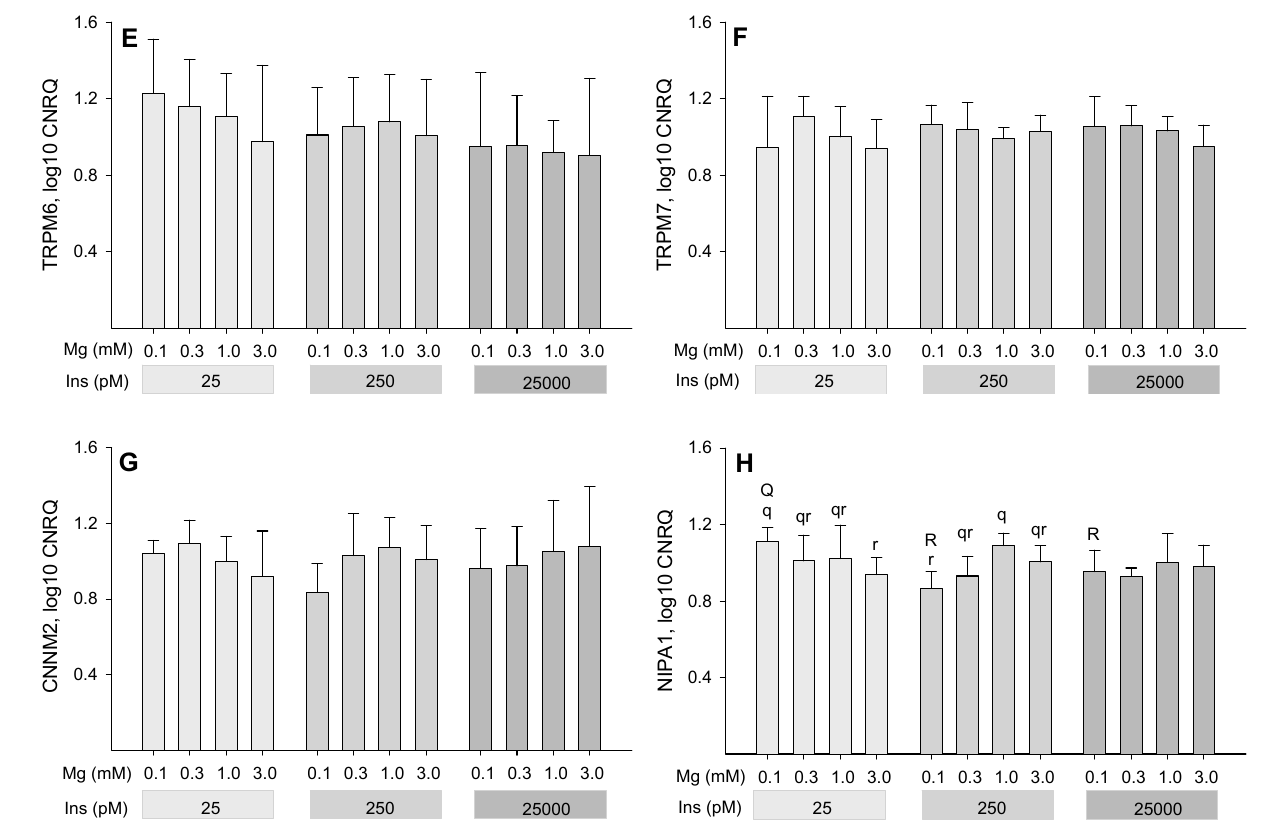
Figure 4. Relative mRNA expression (log10 CNRQ) of magnesium-responsive genes SLC41A1 ( A ), SLC41A2 ( B ), SLC41A3 ( C ), MAGT1 ( D ), TRPM6 ( E ), TRPM7 ( F ), CNNM2 ( G ) and NIPA1 ( H ) in bovine adipocytes. Cells were cultivated in differentiation media containing various concentrations of insulin (Ins) and magnesium (Mg) for 7 days. Results are given as means from six animals ± SD with three replicates. * Asterisks indicate smaller LSM at 3 mM compared to 0.3 mM Mg concentration ( P ≤ 0.05). Superscript letters a and b indicate different LSM for the factor insulin ( P ≤ 0.05). Lower case letters r and q indicate differences within a given insulin concentration ( P ≤ 0.05) and Capital letters R and Q indicate differences within a given Mg concentration ( P ≤ 0.05) whenever interaction between Mg × insulin was significant. The expression of the solute carrier family 41 member 1 ( SLC41A1 ) was affected by both insulin ( P = 0.021) and Mg concentration ( P = 0.050) with no Mg × insulin interaction ( P = 0.72; Figure 4A). Across Mg concentrations, SLC41A1 expression was lower at the extremely low insulin concentration of 25 pM compared to the highest insulin concentration of 25,000 pM ( P ≤ 0.05). Within the significant factor Mg, a trend for down-regulation was observed at the lowest Mg concentration (0.1 mM) compared to the highest Mg concentration (3 mM; P =